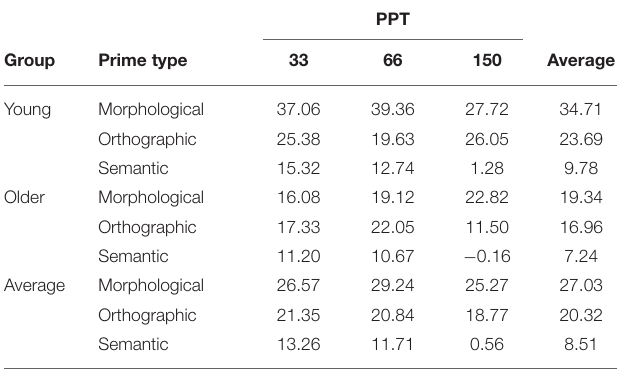
TABLE 3 | Average priming effects for Groups, Prime type and PPT (non-weighted means).